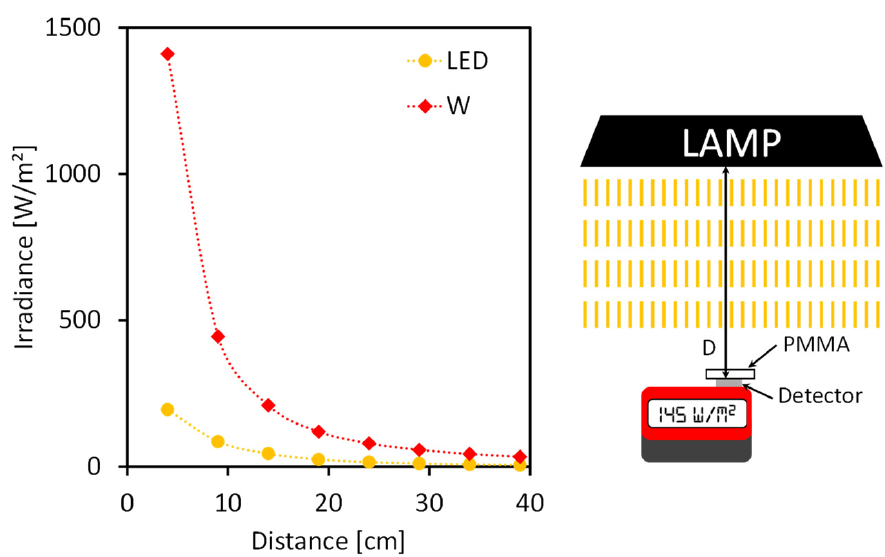
Figure 4. Irradiance of the two used lamps, LED and incandescent, W, through a PMMA window (left) and measuring setup scheme (right).